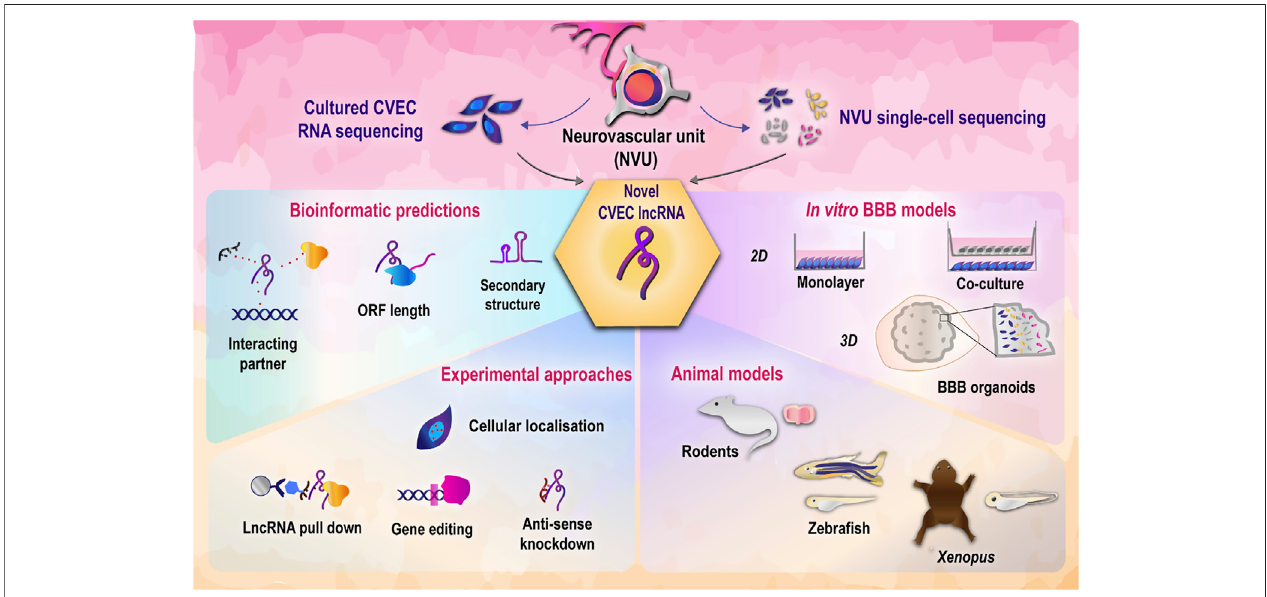
FIGURE 2 | Strategies to decipher functional roles of cerebrovascular endothelial lncRNAs. LncRNAs discovered from cerebrovascular endothelial cells through transcriptomic studies can be functionally validated using a combination of bioinformatics and experimental approaches (Jalali et al., 2015), (McDonel and Guttman, 2019). In vitro and invivo model systemsemployed intandem willallow indecipheringthephysiological rolesoflncRNA incerebrovascularendothelialfunction(Jackson et al., 2019). CVEC, cerebrovascular endothelial cells; BBB, blood brain